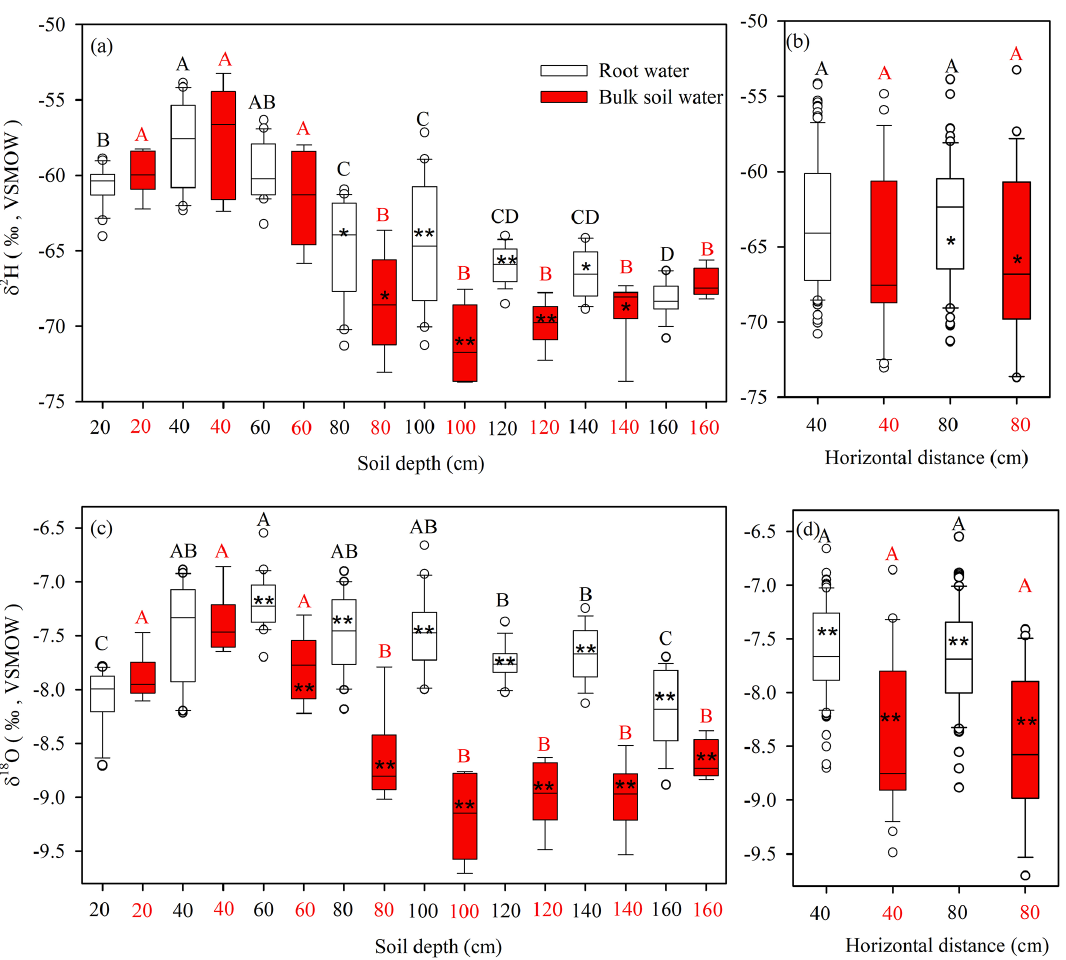
Figure 5. Boxplots of stable isotope compositions of root water and bulk soil water ( δ 2 H and δ 18 O) at indicated depths (a, c) , and horizontal distances from the tap root of the focal root system (b, d) . The top and bottom of each box are the 25th and 75th percentiles of the samples, respectively. The black line in each box is the sample median. Asterisks indicate significantly different isotopic compositions of soil water and root water ( ∗ and ∗∗ p< 0 . 05 and p< 0 . 01, respectively, according to two-tailed tests). Stable isotope compositions of plant root water or bulk soil water at different depths that do not share a letter are significantly different ( p< 0 . 05, Tukey–Kramer